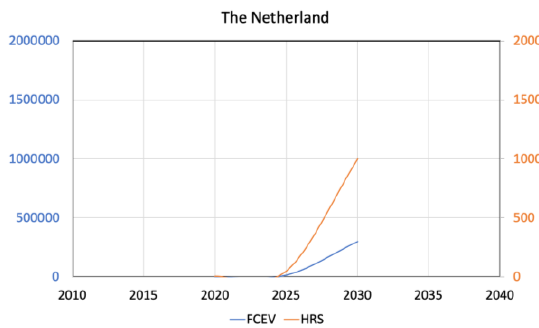
Fig. 5. The number of HRS and FCEVs in the Netherlands (2017–2030) Norway Norwegian greenhouse gas emissions were 52 million tonnes of CO equivalents in 2018. Road traffic is responsi- 2 ble for 16.5 million tonnes CO equivalents and 32% of 2 total emissions. Hydrogen and other hydrogen-based sys- tems have the potential to reduce emissions in the transport sector [44].